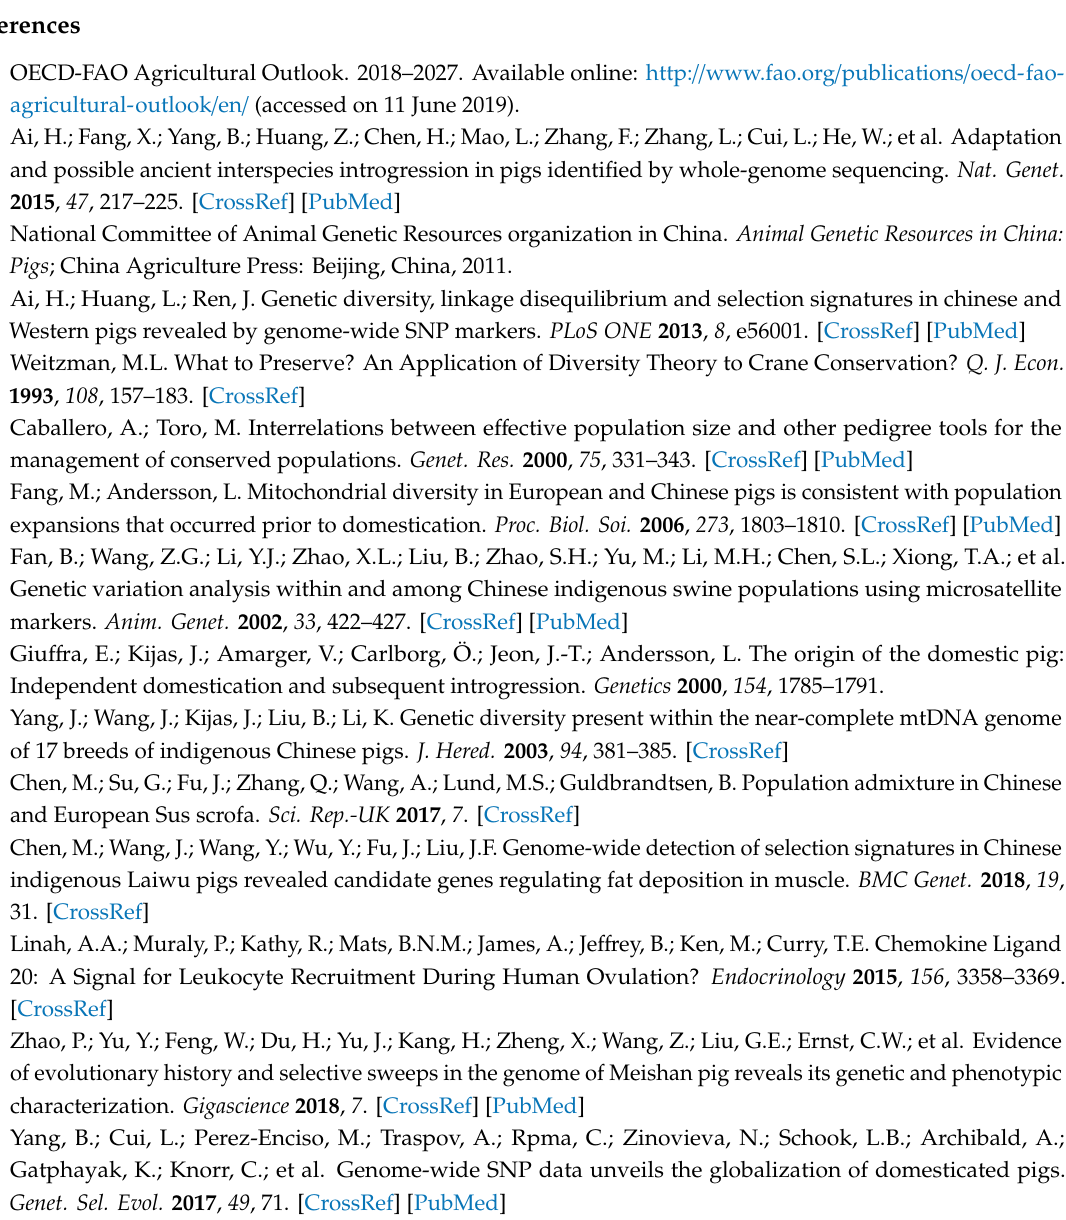
S4: The likelihood of K in structure analysis; Figure S5: Structure results among South China indigenous pig breeds; Figure S6: The likelihood of K in structure analysis among South China indigenous pig breeds; Figure S7: The predicted r 2 of di ff erent distances and true r 2 ; Table S1: The genetic distance of each individual; Table S2: Parameters of linkage disequilibrium decay model of each breed; Table S3: Candidate genes and Quantitative Trait Locus (QTLs) overlapped with potential selection regions; Table S4: F ST of all SNPs; Table S5: Gene Ontology (GO) terms and Kyoto Encyclopedia of Genes and Genomes (KEGG) pathways enriched with candidate